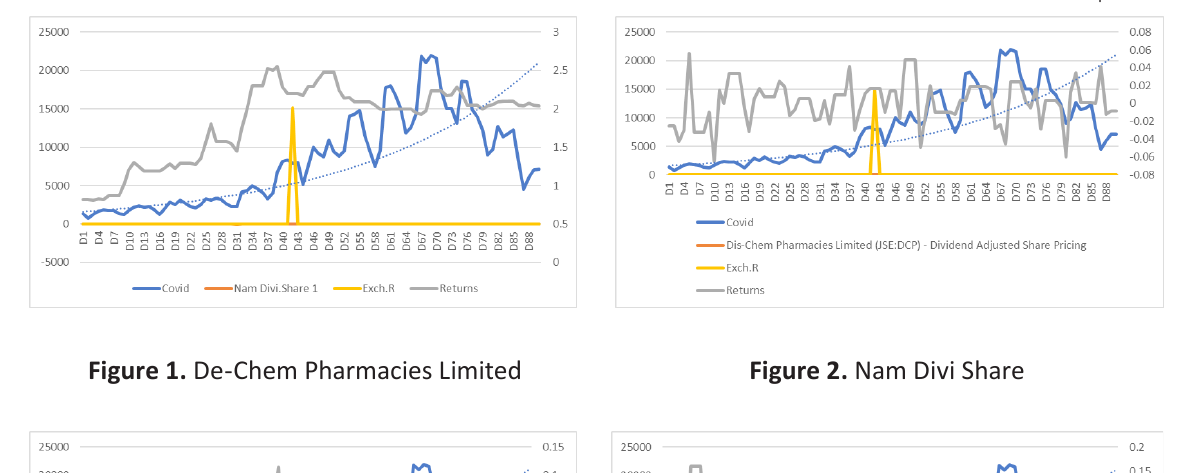
Figure 4. MTN Group Limited